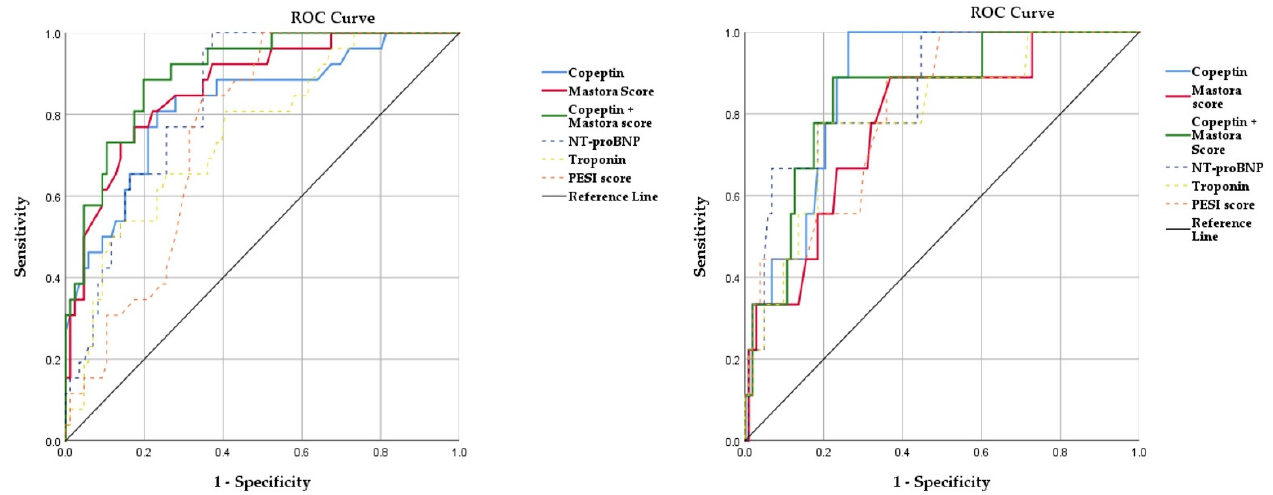
Figure 4. ROC curves for prediction of adverse events ( left ) and death ( right ).